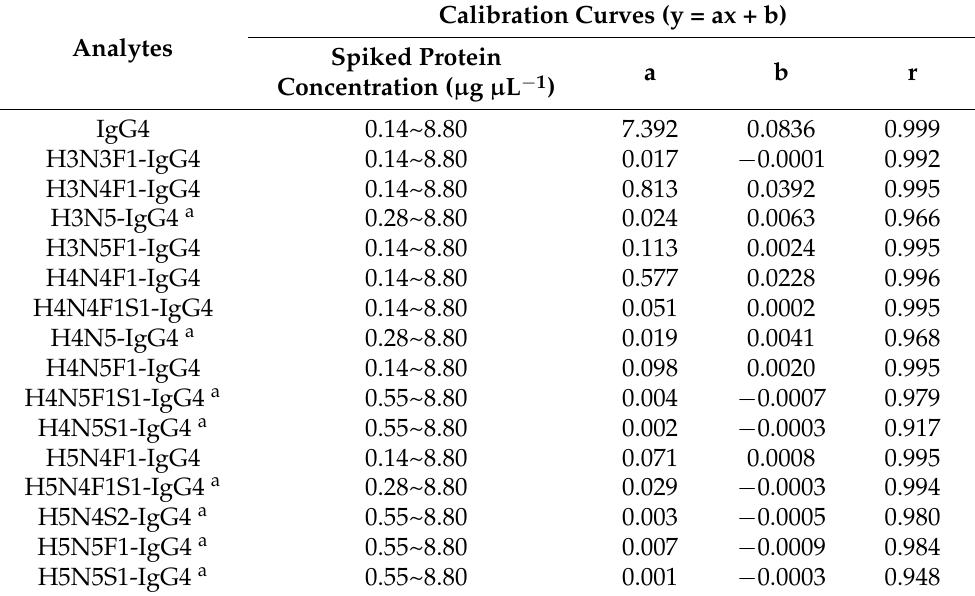
Table 2. The calibration curves for IgG4 and 15 IgG4 glycopeptides.